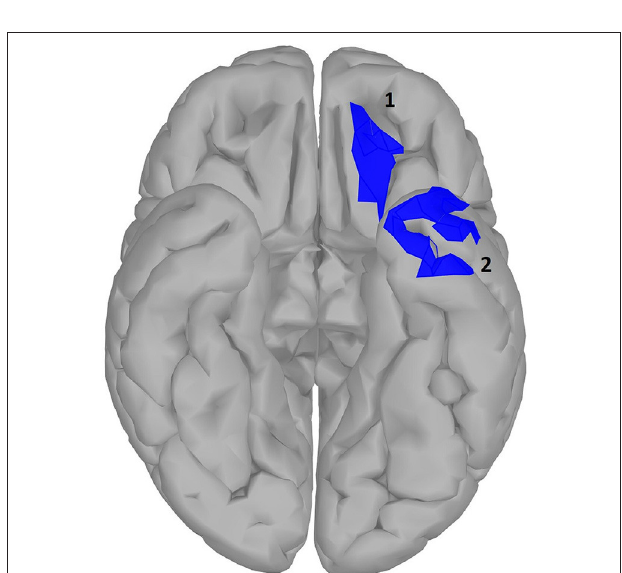
FIGURE 6 | significance map for arousal.